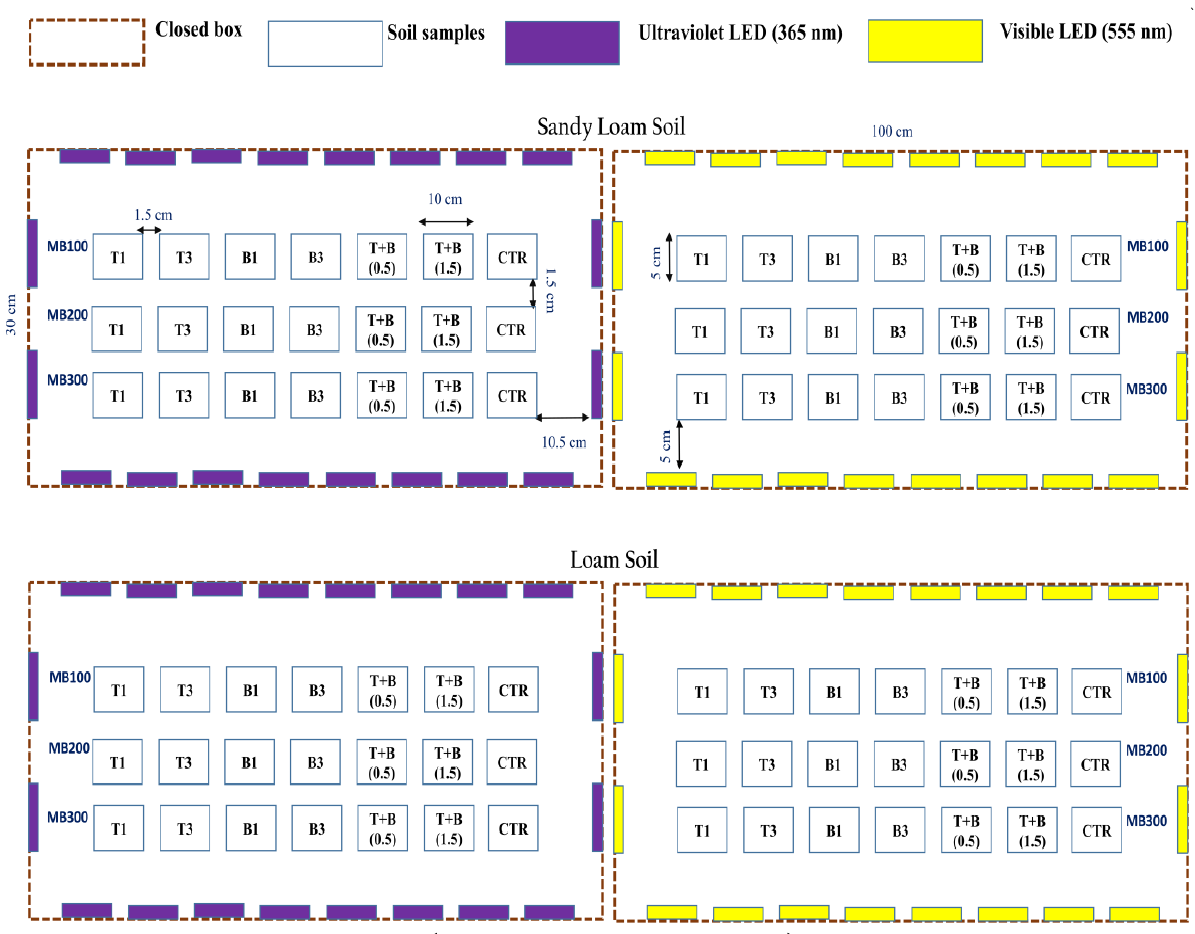
Fig. 1. Schematic of experimental setup (each soil sample in three